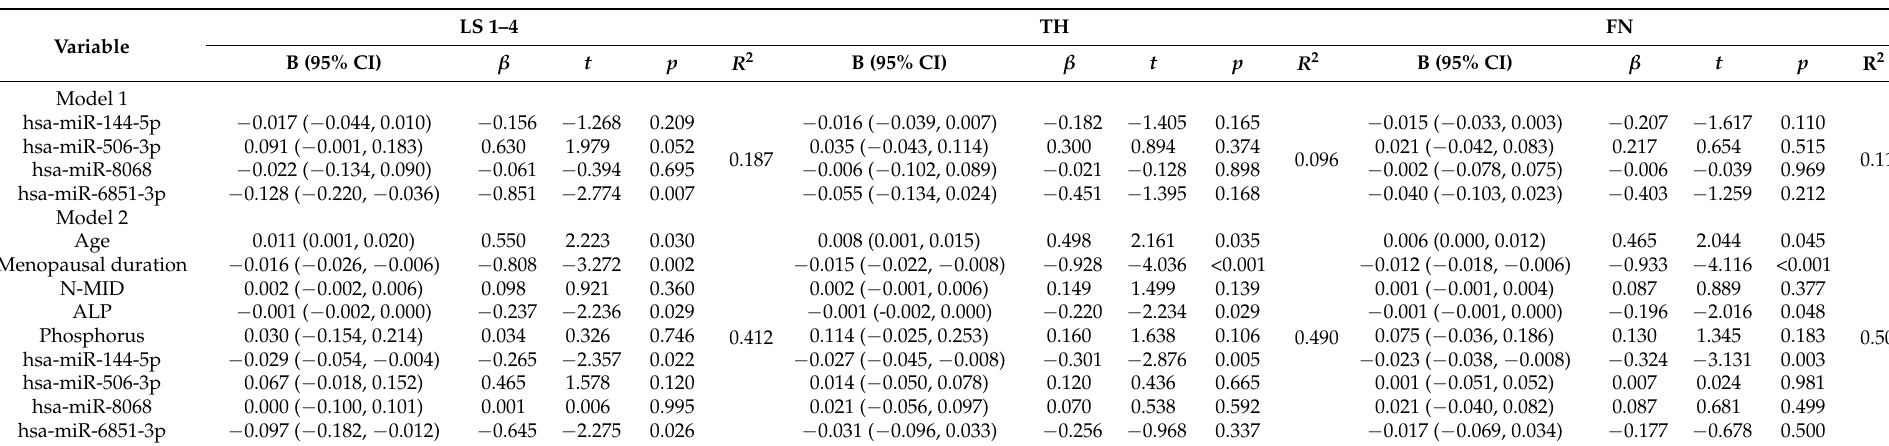
Table 4. Linear regression analysis of the factors influencing BMD (g/cm 2 )